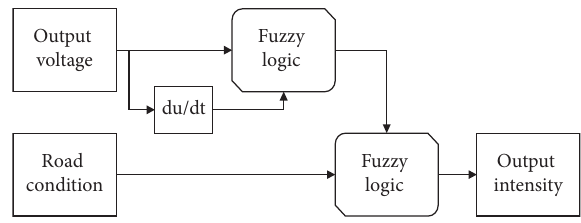
Figure 3: The structure of the braking intention